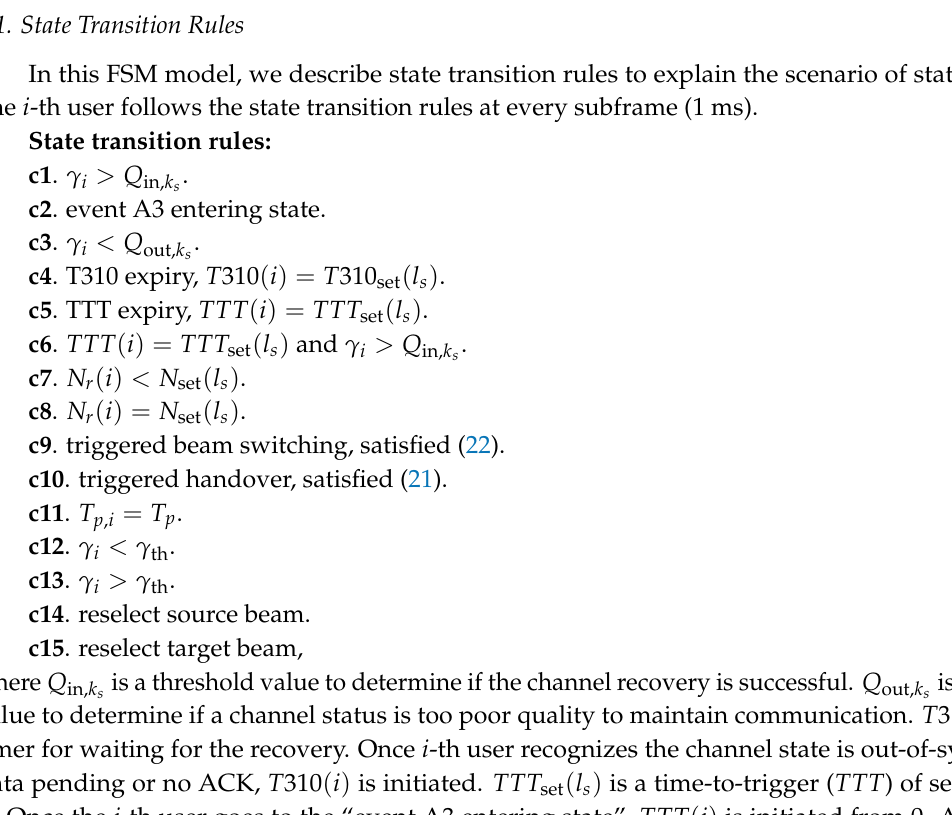
Figure 3. User finite state machine for proposed